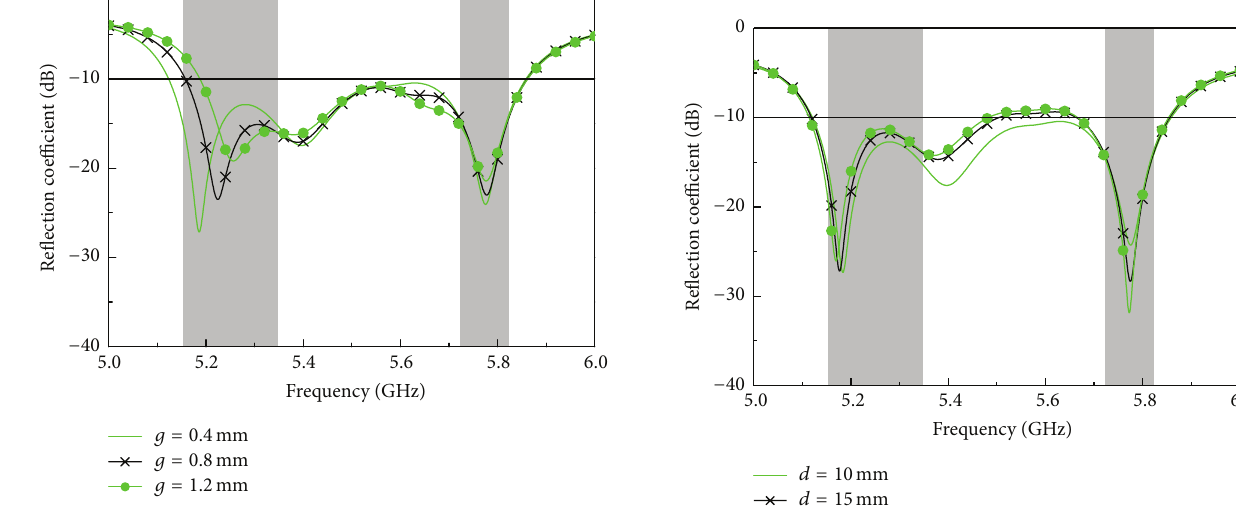
Figure 7: Simulated reflection coefficients for various values of gap distance 𝑔 .